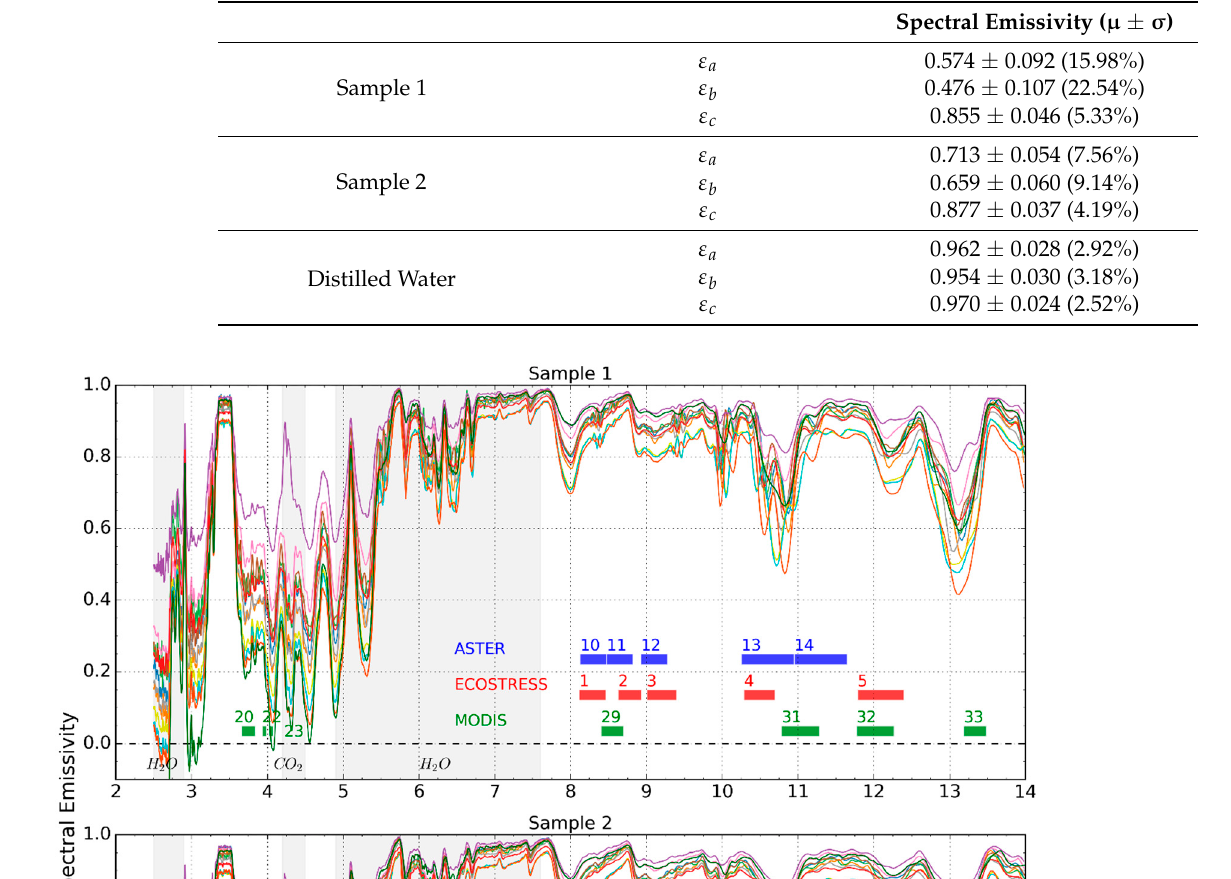
of calibration, using identical measurement setups, parameters and procedures. The absorption bands of relevant gases (H 2 O and CO 2 ) are indicated through the grey vertical bars. Table 3. Mean ( µ ) and standard deviation ( σ ) of SE ( ε ) for each sample averaged over a specified wavelength range, calculated using all spectra. The number in brackets shows the standard deviation as a percentage of the mean. The subscripts a, b and c refer to the wavelength ranges averaged over, where a = 2.5–14 µ m, b = 3–5 µ m (MWIR region) and c = 8–14 µ m (LWIR region).